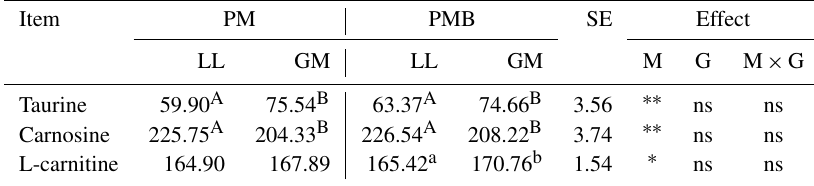
Table 5. The taurine, carnosine, and L-carnitine concentration for different genotypes and muscles (mg100g − 1 of meat). Item PM